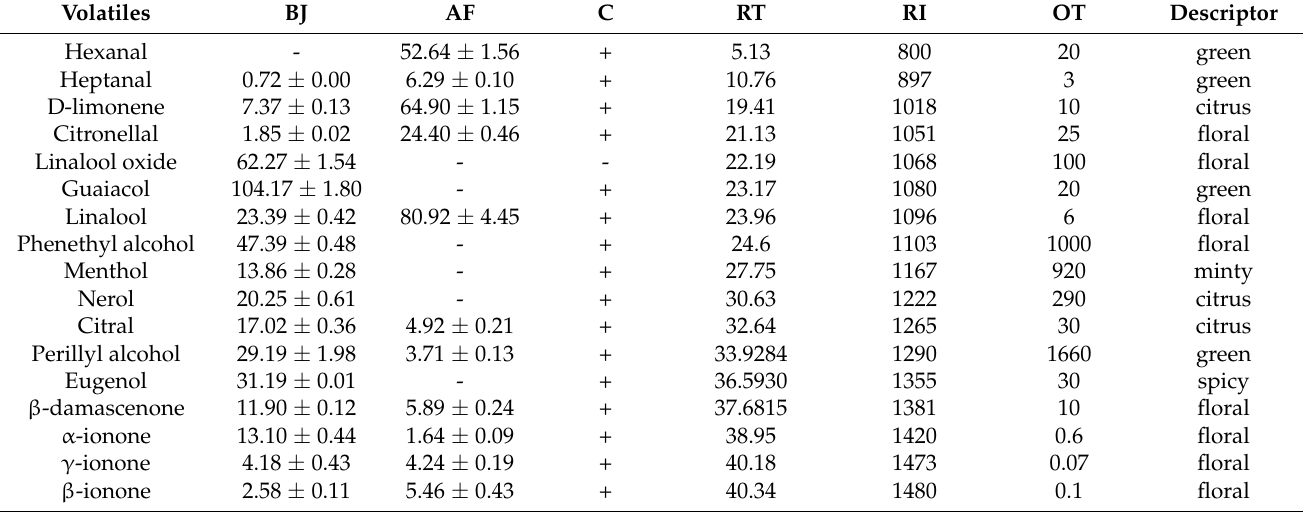
Table 5. Volatile compounds ( µ g/kg) defined in blackberry juice (BJ), apple fiber (AF), and formulated microparticles ©, their odor threshold, and the flavor